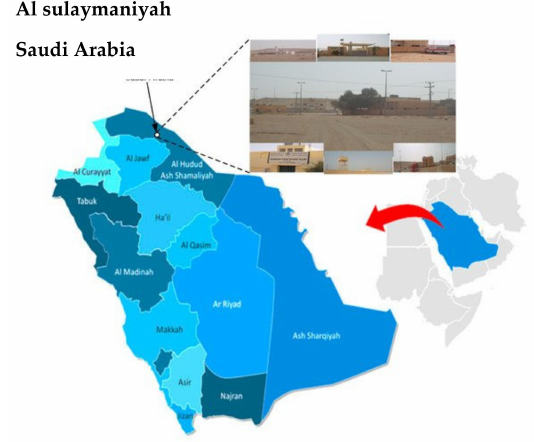
Figure 2. Al Sulaymaniyah village, Saudi Arabia.